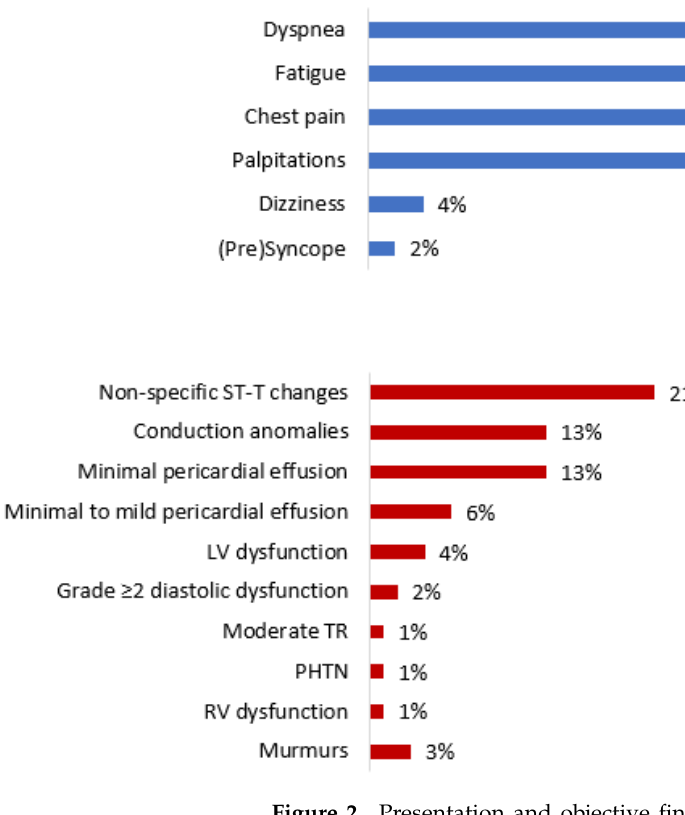
Figure 2. Presentation and objective findings demonstrated in Long-COVID Patients with suspected cardiovascular symptomatology. Among long-COVID outpatients assessed at a dedicated ‘Cardio’-COVID clinic due to suspected cardiovascular symptomatology, the leading symptoms at the initial visit were mainly non-specific, such as dyspnea and fatigue. Electrocardiographic aberrations were the most common objective findings and mainly included non-specific ST-T changes. COVID = coronavirus disease; CV = cardiovascular; LV = left ventricular; PHTN = pulmonary hypertension; RV = right ventricular; TR = tricuspid regurgitation.